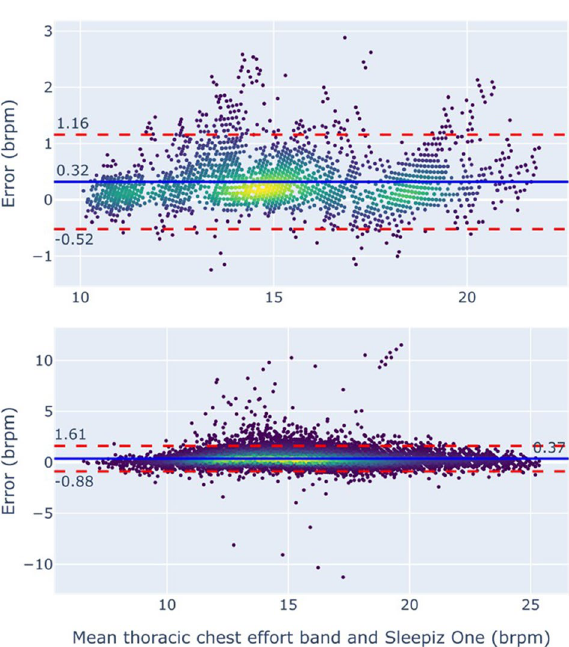
Figure 5. Bland–Altman plot of instantaneous respiratory rate performance. Top: results from Study 1. Bottom: results from Study 2. The solid blue line indicates the bias, while dashed red lines correspond to the 95% limits of agreement.